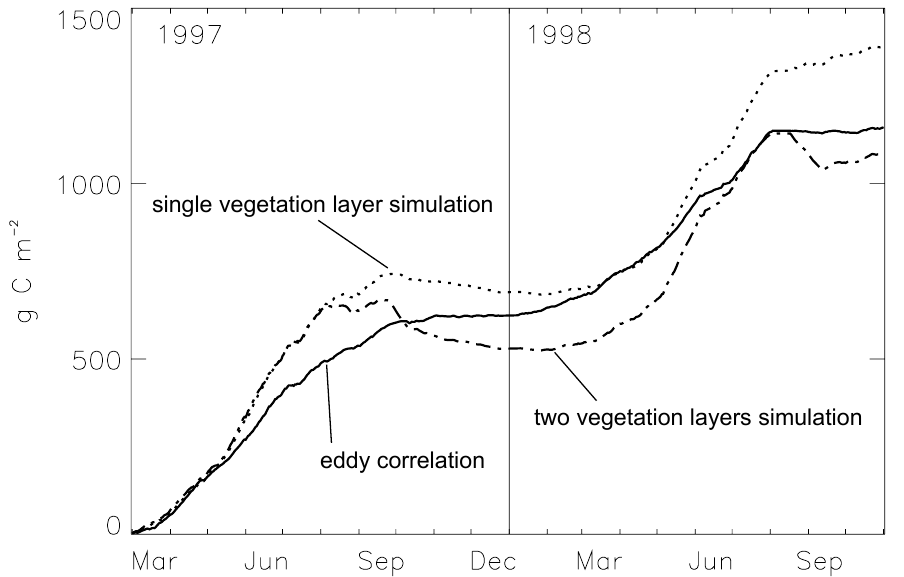
Fig. 5. The 2-year evolution of the cumulative daily net carbon storage (NEE) for the Le-Bray forest, as estimated from eddy correlation measurements and ISBA-A-g s simulations (solid and dotted or dashed lines, respectively). The missing half-hourly data of the observed time series (9.4%) and the corresponding simulated values were replaced by zero values. Two simulations are displayed: assuming that the canopy consists of either a single layer of maritime pine or accounting for the characteristics of the purple moor-grass undergrowth (dotted and dash-dotted lines, respectively).